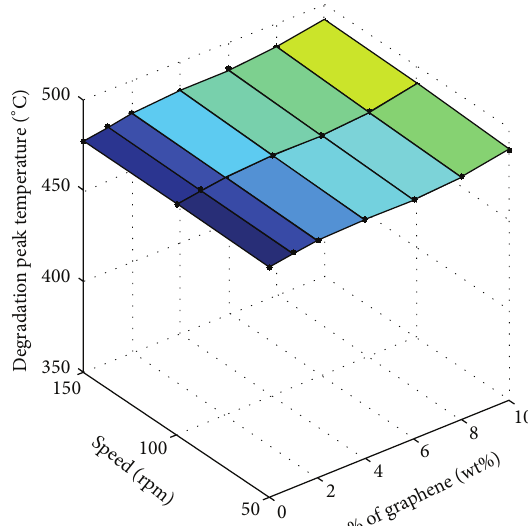
Figure 11: Predicted crystallization temperature of LLDPE/GNPs composites as a function of C-GNPs wt% and different speeds of LLDPE/GNPs composites. The measured data are plotted as black points.